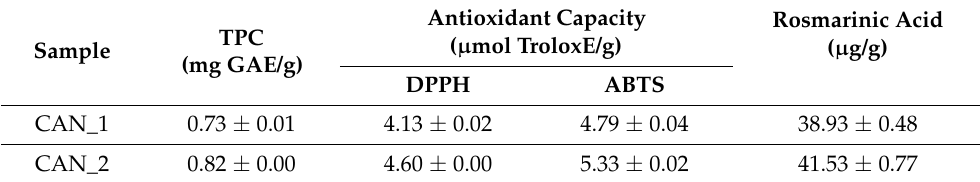
Table 5. Bioactive characterization of formulated